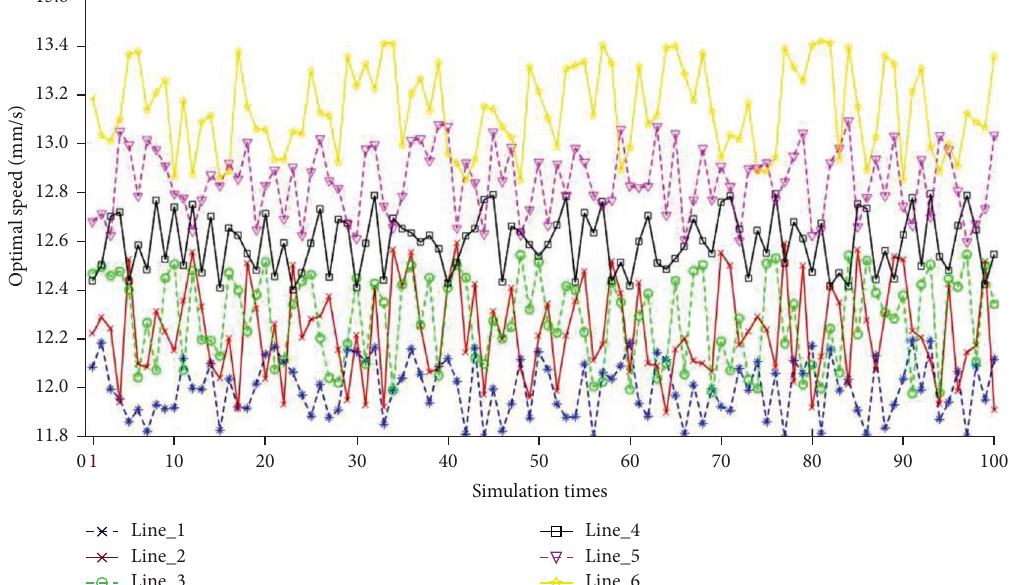
F IGURE 10: Simulation results of optimal puncture speed of prostate soft tissue (cancer) with different elastic